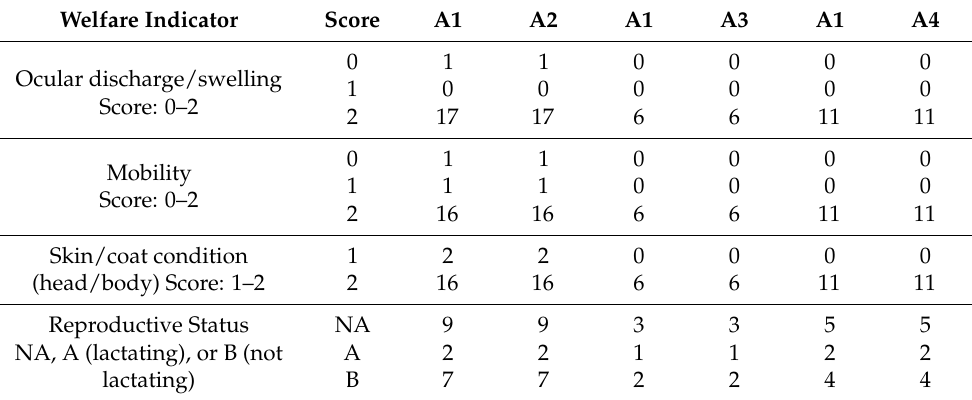
Table 4. Welfare scores for indicators with 100% agreement listed by assessor. These indicators were excluded from further analysis. Assessor 1 (A1) (primary investigator) assessed n = 35 ponies along with one of the other assessors; A2 ( n = 18), A3 ( n = 11), and A4 ( n =